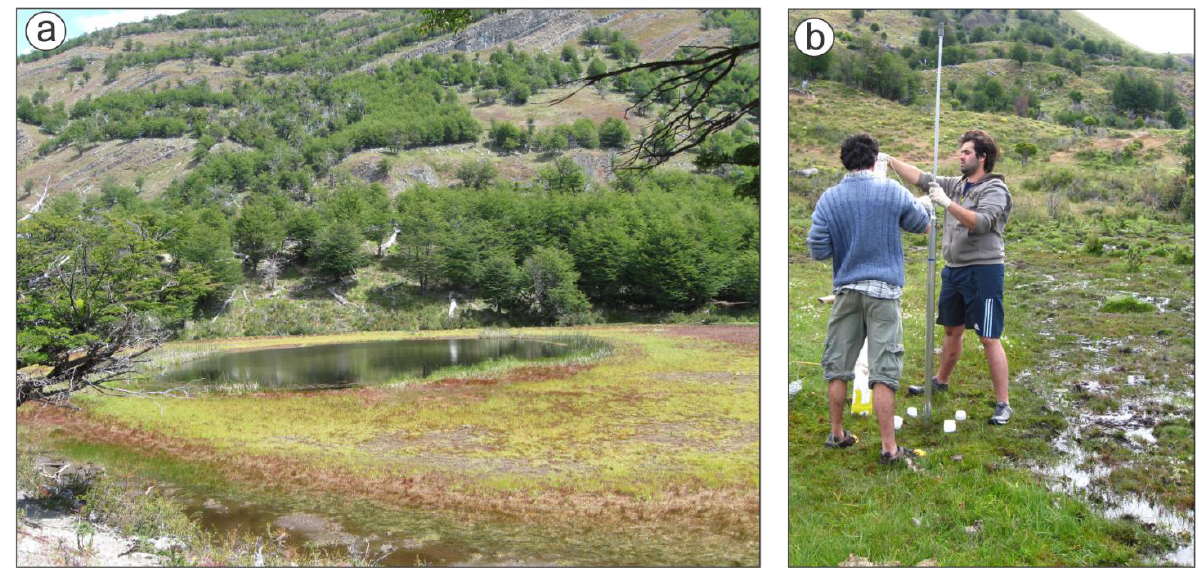
Figure 2. Photographs of the cored peat bogs: (a) Península Avellaneda Alto; (b) Península Avellaneda